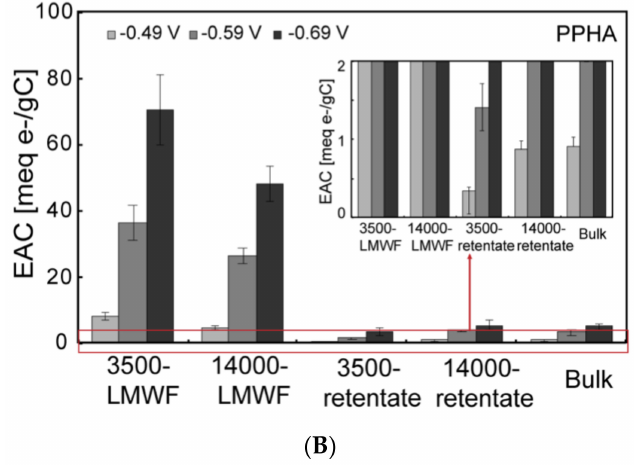
Figure 4. The EAC of different molecular weight fractions of HA under E h = − 0.49 V, E h = − 0.59 V, and E h = − 0.69 V direct electrochemical reduction experiments. ( A ) LHA; ( B ) PPHA.